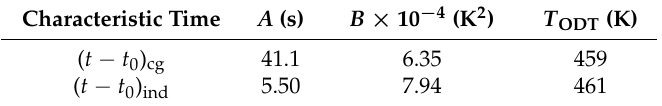
Figure 7. The reduced critical gel and induction times as a function of the absolute temperature. The solid lines are the non-linear regression fits of Equation (2). Table 3. The fitting parameters of Equation (2) for the reduced critical gelation and induction